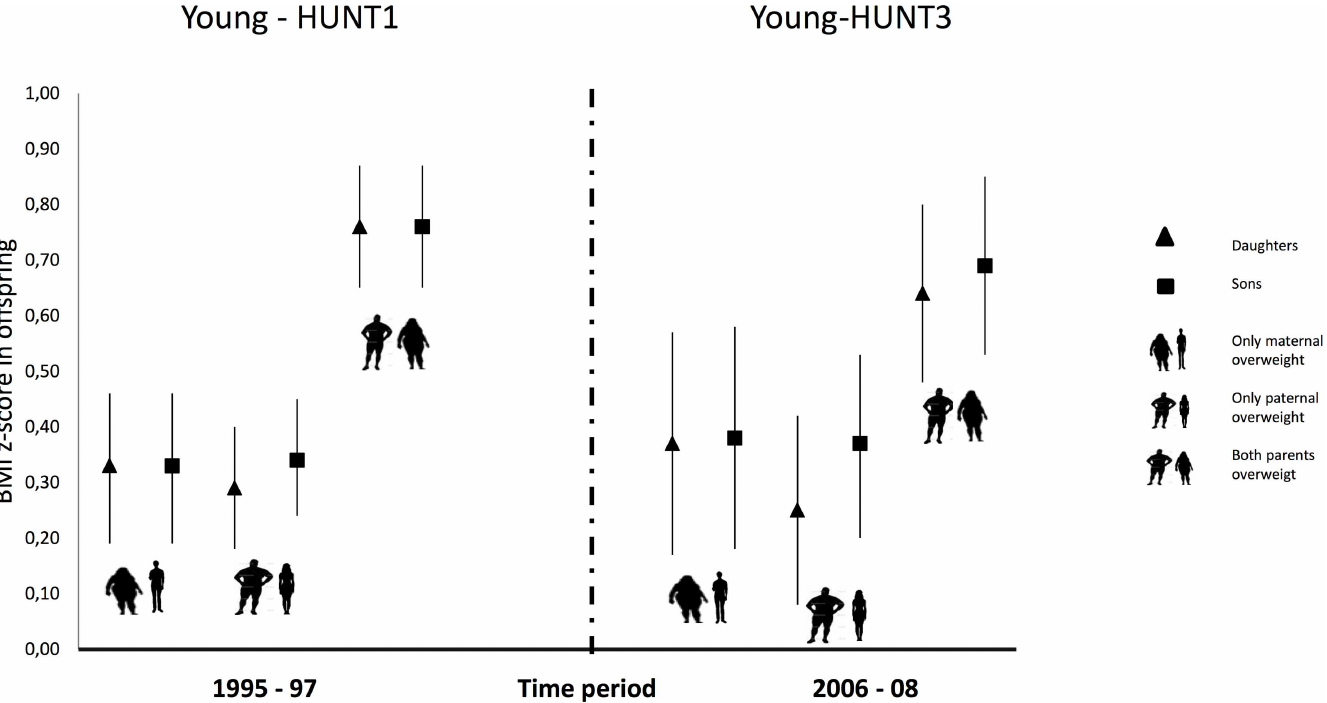
Fig 2. Associations in BMI. Associations betweenparentalBMI-based overweight (BMI (cid:21) 25) and offspring‘s BMI z- scores at two time points (1995–97 and 2006–08)with both parents being overweight, only mothers being overweight and only fathers being overweight, compared to both parents being normal weight (BMI <